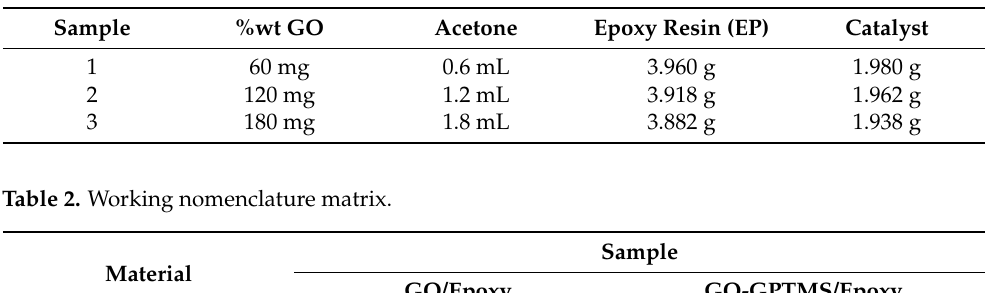
Figure 2. Synthesis of functionalization process of GO with GPTMS. Table 1. Weight concentration of GO and elements constituting the nanocomposites.